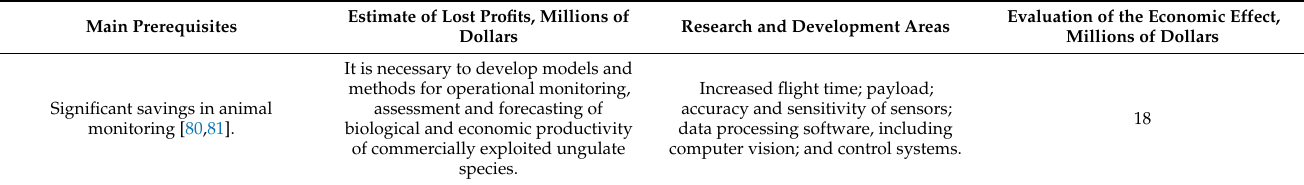
Table A5. IUAVT use for wildlife monitoring objectives.